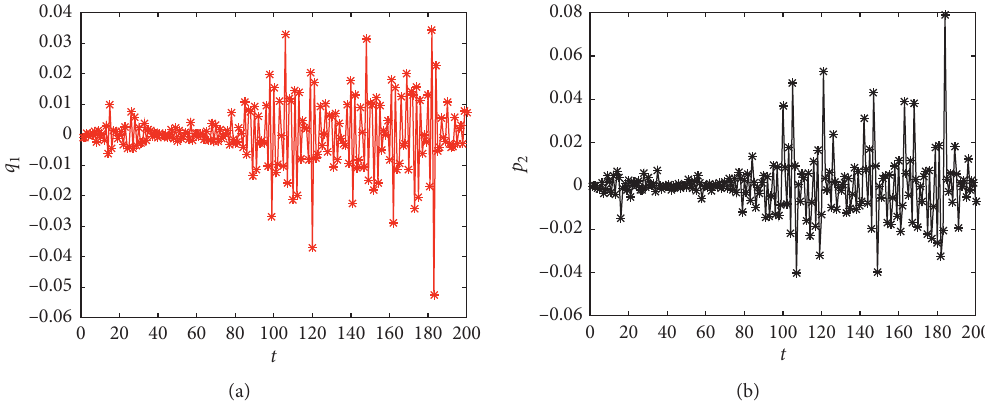
Figure 7: Sensitivity to the initial value when ( q